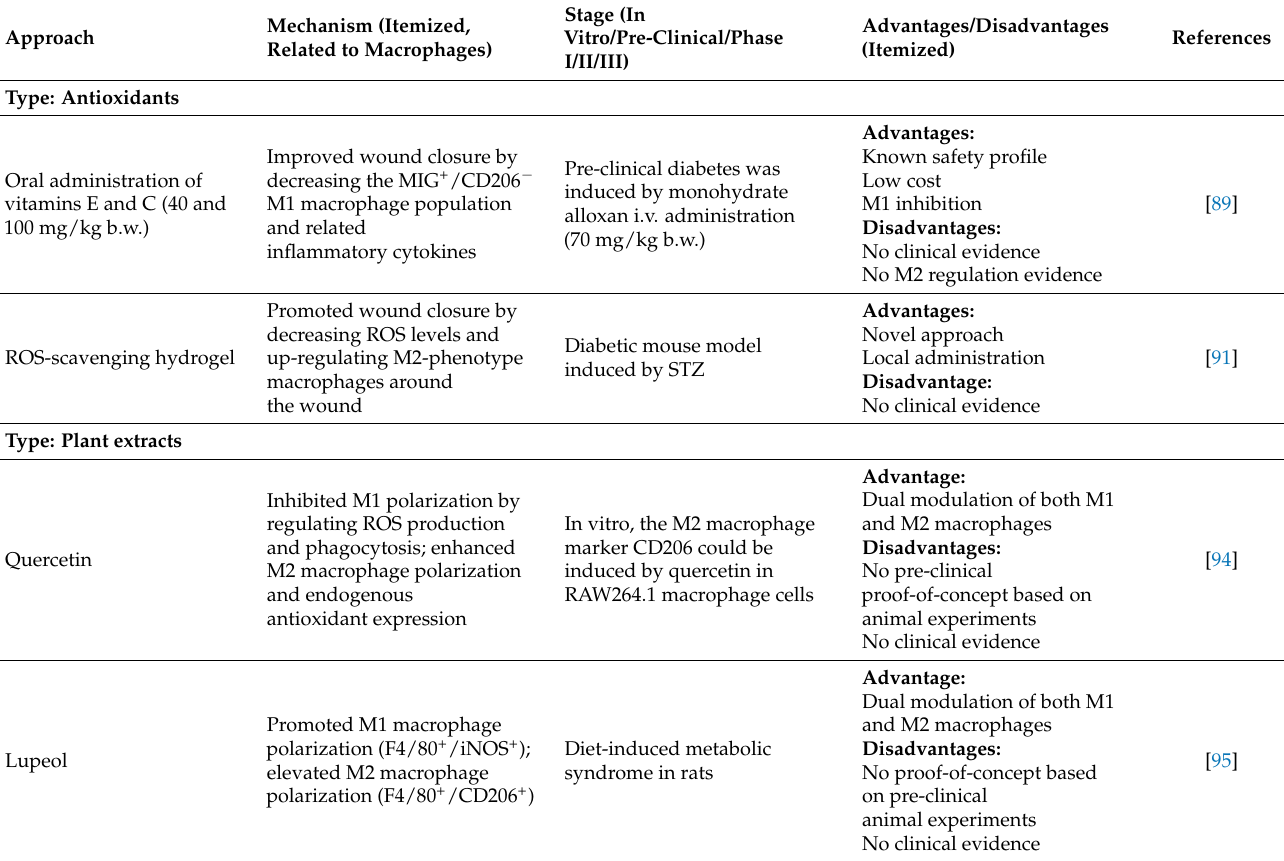
Table 1. List of novel macrophage-regulating approaches for DFU